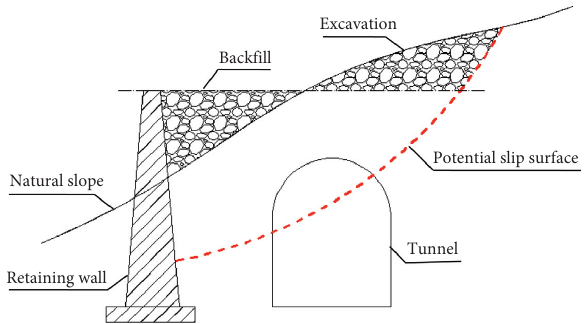
Figure 2: Schematic diagram of reloading